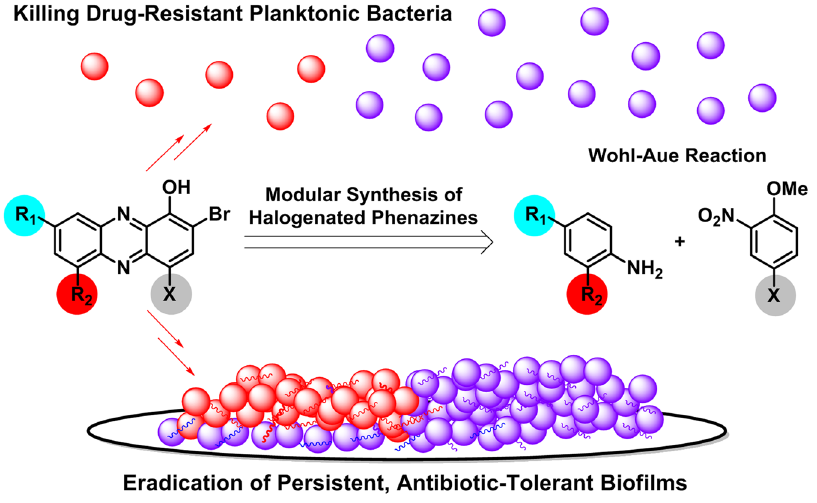
Figure 9. Development of a modular synthesis to a diverse array of halogenated phenazines that target both planktonic and biofilms